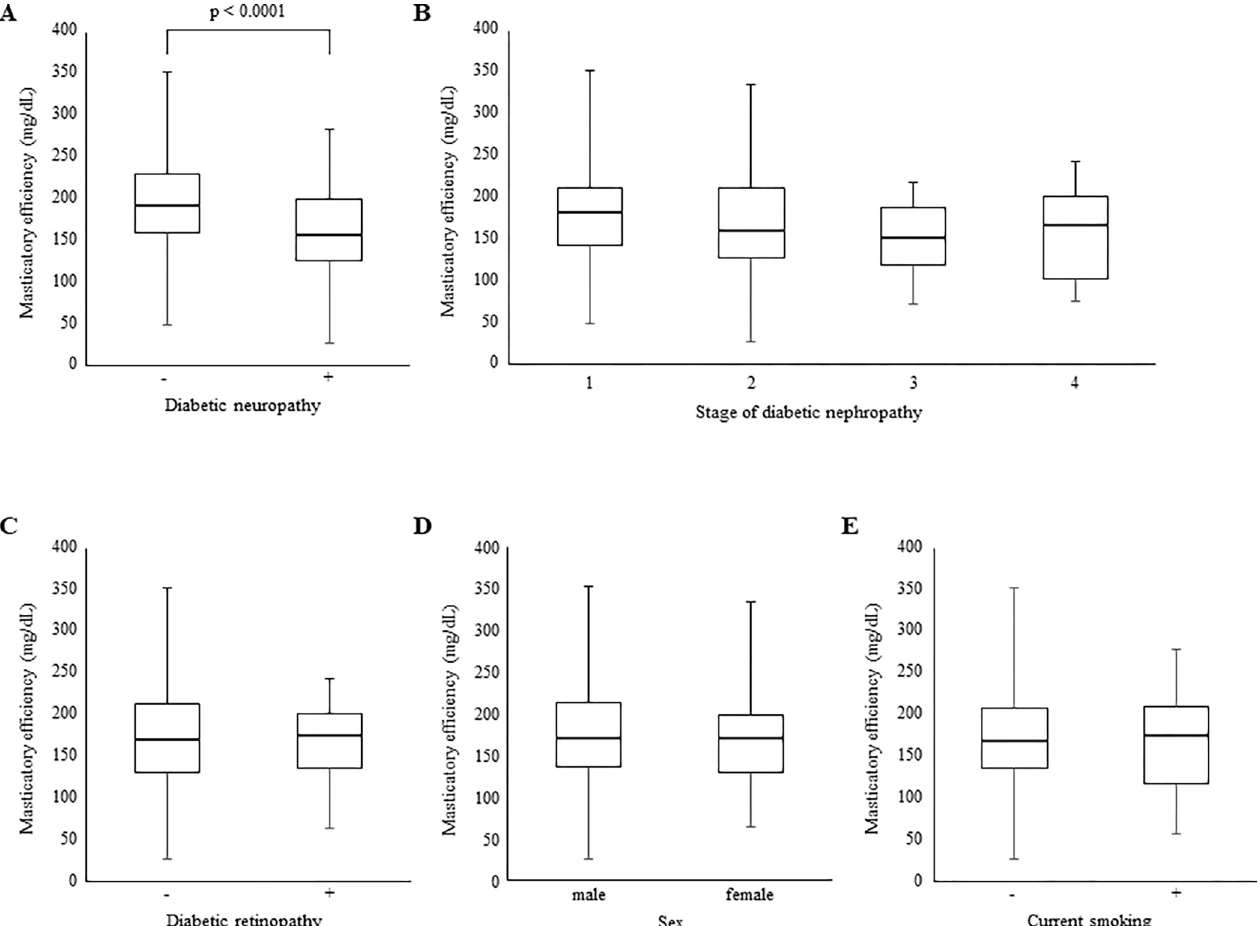
Fig 2. One-way ANOVA and the t-test. Effects of (A) diabetic neuropathy, (B) stage of diabetic nephropathy, (C) diabetic retinopathy, (D) sex and (E) current smoking on masticatory efficiency were assessed. Statistical significance was defined as a two-sided p value of < 0.05.